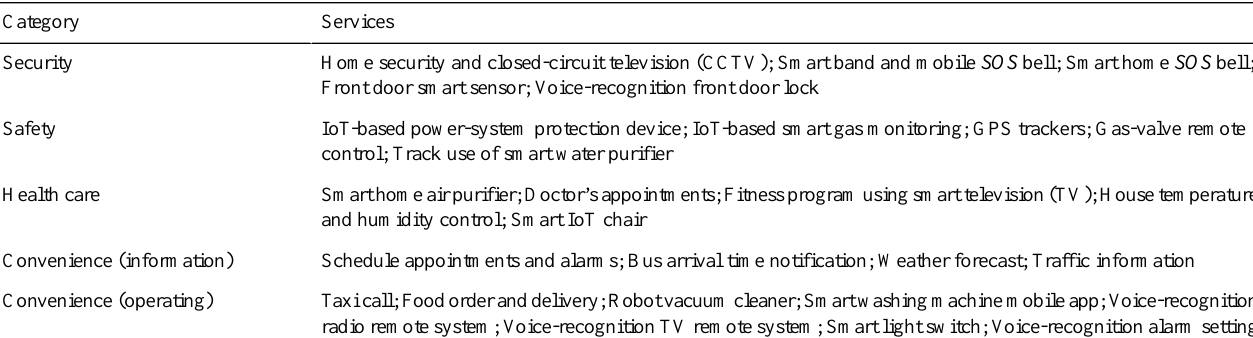
Table 1. Available Internet of Things (IoT) services by category.